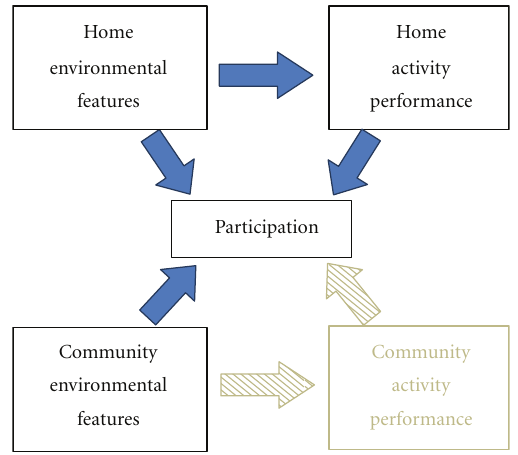
Figure 1: Based on the ICF, environmental press, and life space models, the conceptual framework for the study illustrates the relationship between home and community environmental features and home and community activity performance, respectively. In addition, activity as a prerequisite for participation suggests that home and community activity performance, in turn, influence participation in both settings although, as indicated by the dark filled arrows, this study only examined the relationships between community participation and (1) home and community environ- mental features and (2) home